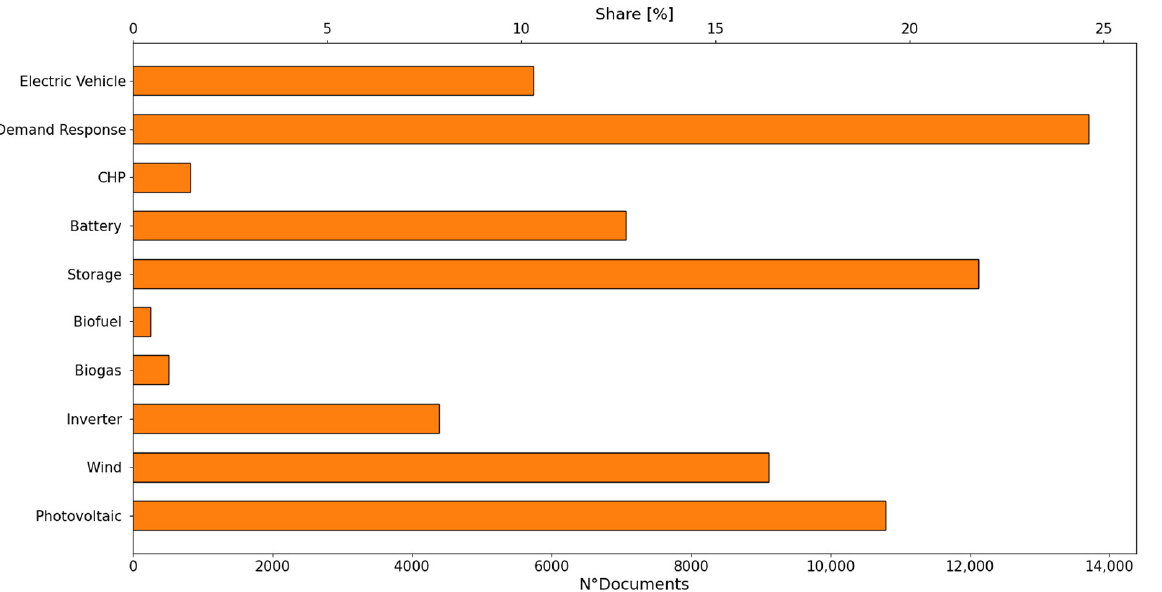
Figure 4. Number of articles, including keywords, related to the topic of interest (technological aspects related to the provision of flexibility by DERs), both in absolute terms and percentage with respect to the total number of documents.